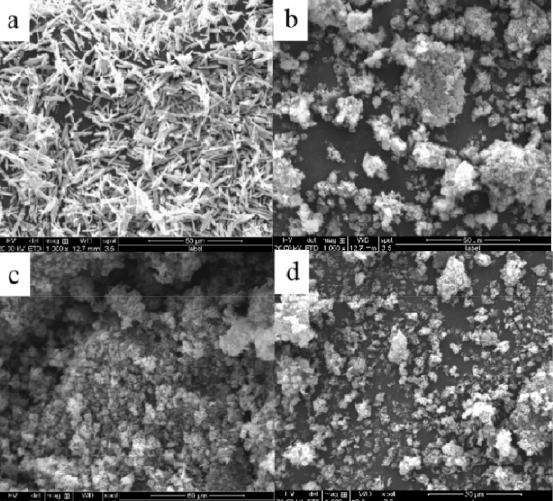
Figure 1. SEM images of ZnO ( a ) and PANI composites with different amounts of ZnO, ( b ) 0; ( c ) 8% and ( d )